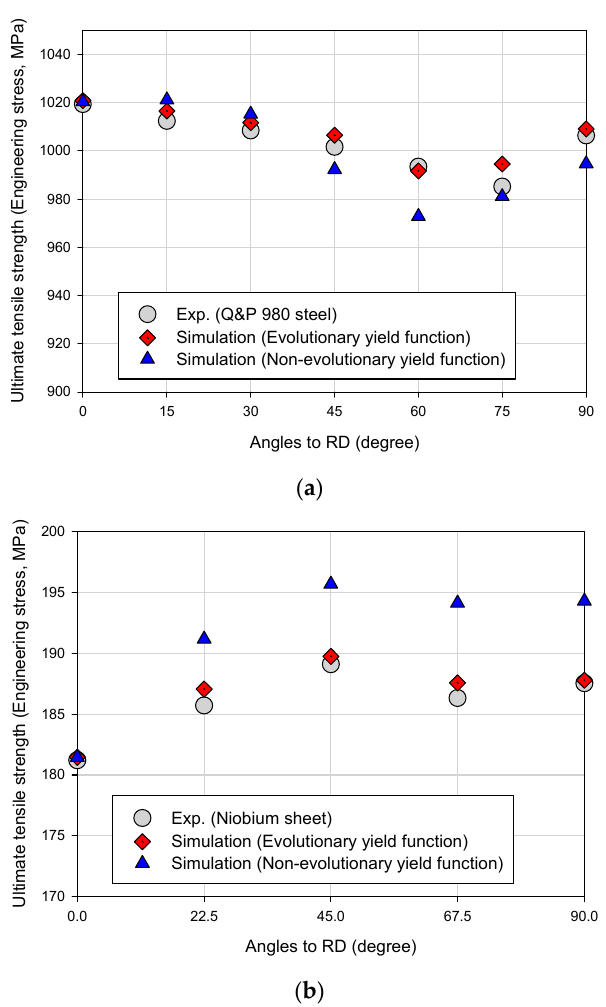
Figure 17. Comparison of the measured and simulated ultimate tensile strength (UTS) distributions for ( a ) the Q&P 980 steel and ( b ) niobium sheet.